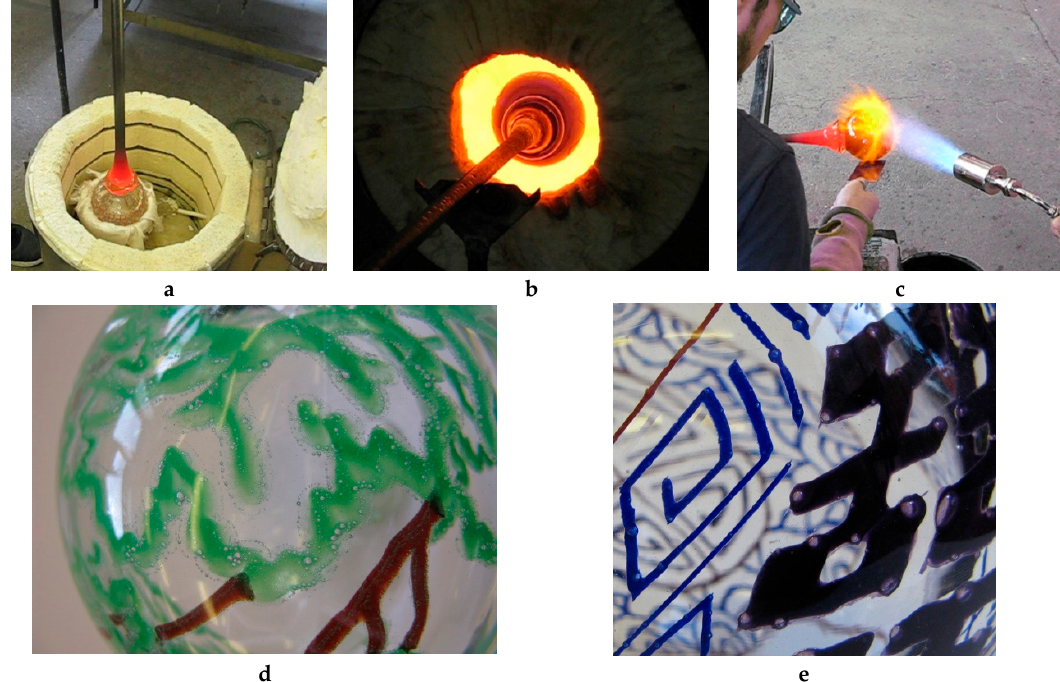
Figure 11. ( a – c ) Picking up the parison from the pick-up kiln. ( d , e ) Bubbles on the colour.